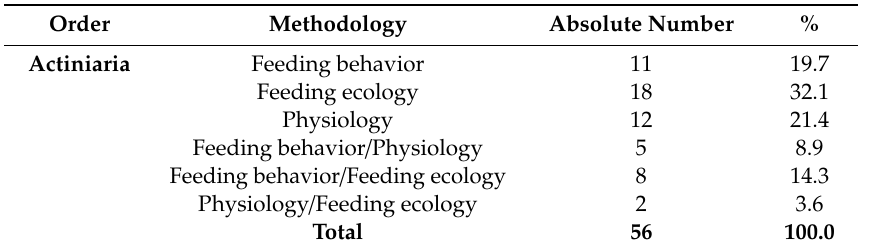
Table 3. Approaches of feeding studies examining Actiniaria.